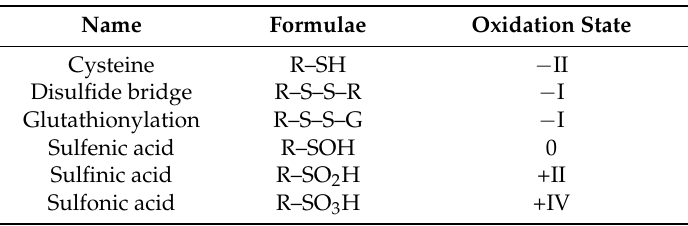
Table 1. Redox cysteine oxidation